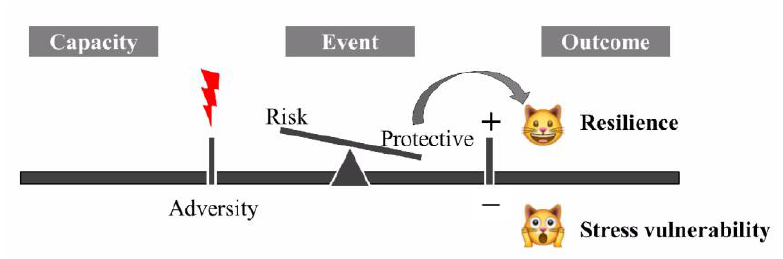
Figure 1. The mechanism of systemic